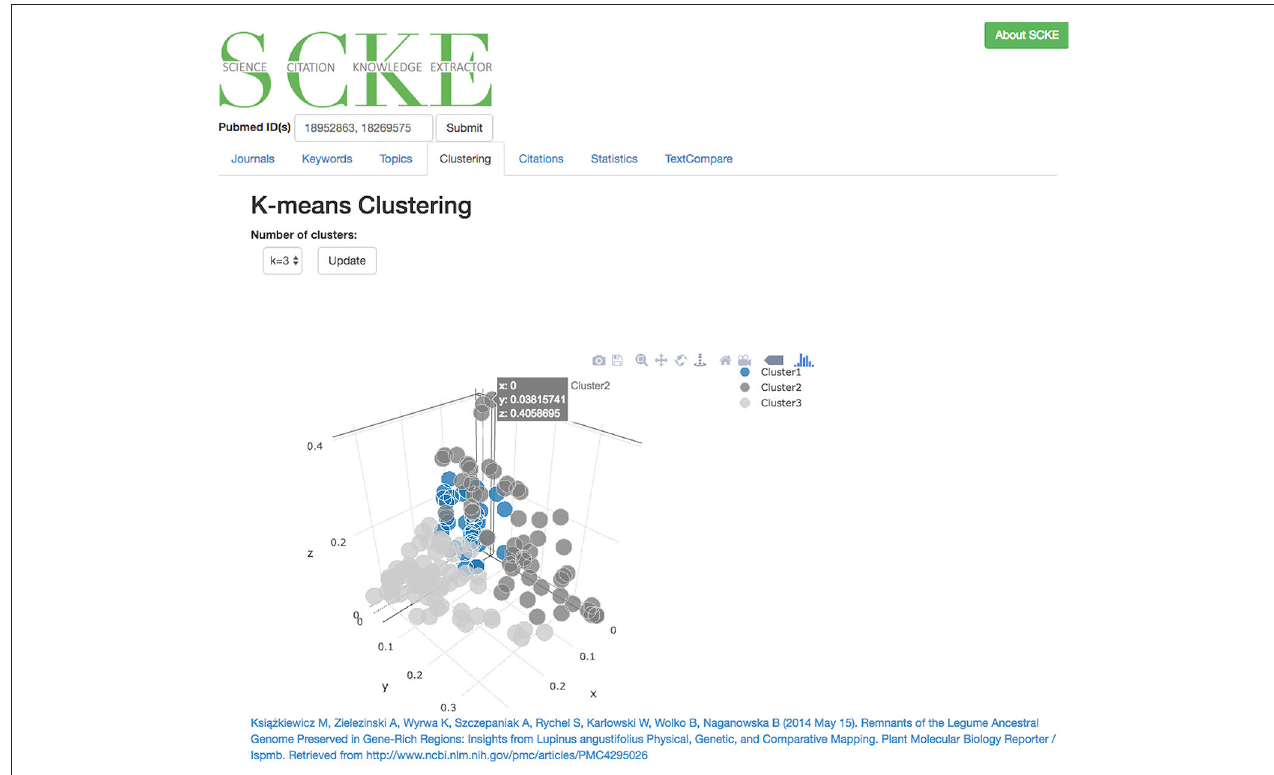
FIGURE 9 | Interactive 3D plot of clustered documents. Users can navigate the space to see which documents are more or less similar. Clicking on the points in the graph will display a link back to the original document.